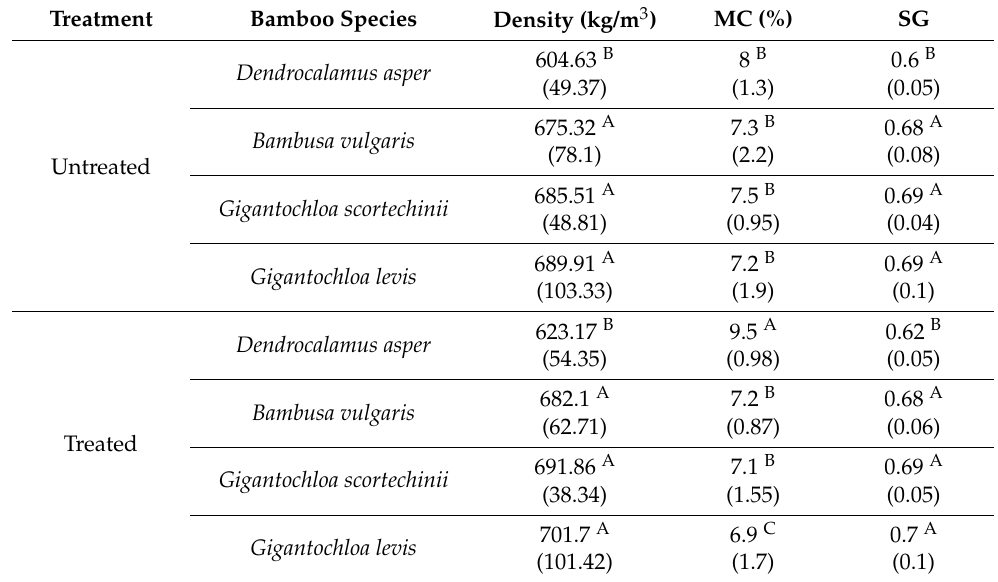
Table 4. Density and specific gravity of treated and untreated bamboo strips of four selected species.